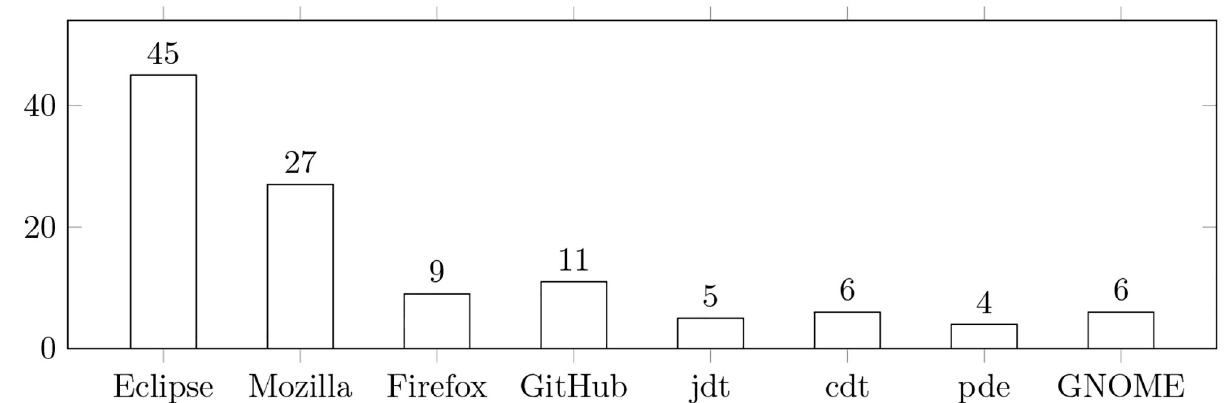
Fig 10. Distribution of datasets. The bars show the number of papers in which the specified algorithms were considered. Note: several datasets could be considered in one paper.